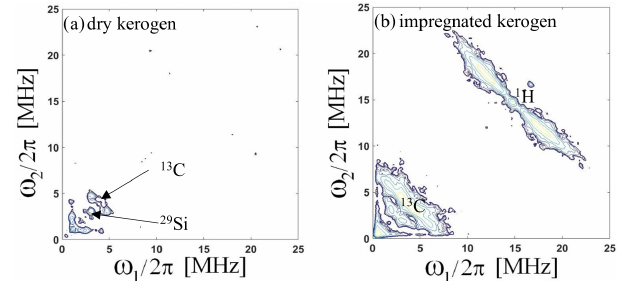
Figure 7. (a) Two-dimensional HYSCORE of carbon-centered rad- icals of extracted kerogen and (b) extracted kerogen impregnated with dodecane model oil. All spectra are recorded at